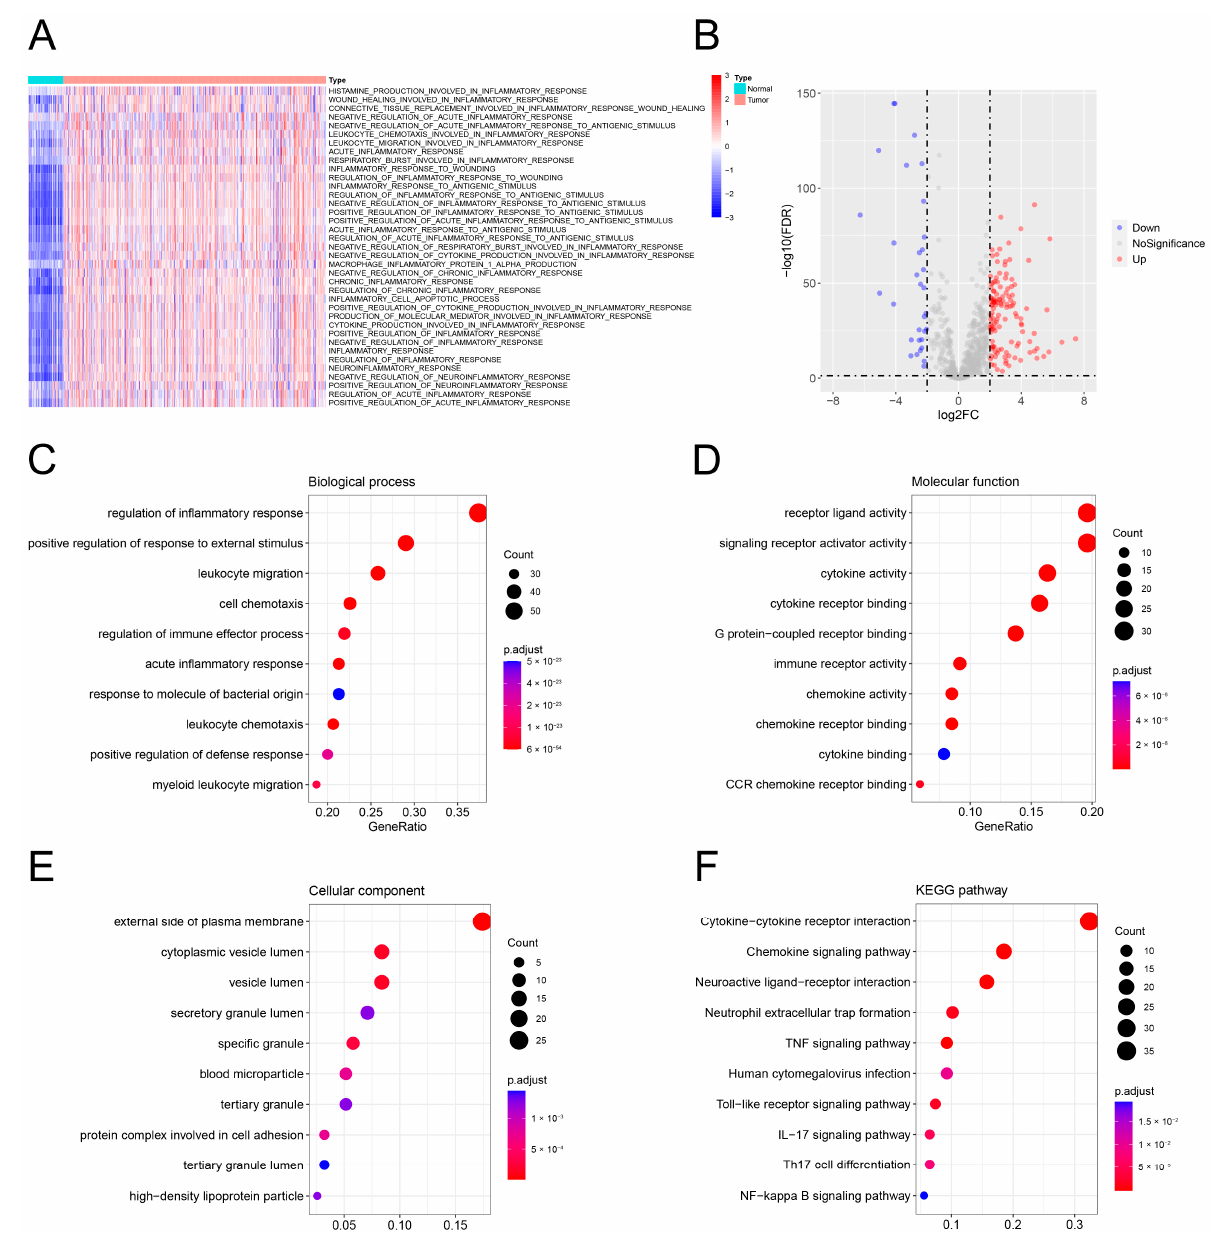
Figure 1. Inflammation-related biological functions were activated in ccRCC. ( A ) Functional enrichment of 37 inflammation-related BP terms in healthy kidney tissues and ccRCC tissues. ( B ) Inflammation-related DEGs between healthy and ccRCC kidney tissues. ( C – F ) Functional enrichment of inflammation-related DEGs by GO and KEGG pathway analyses.